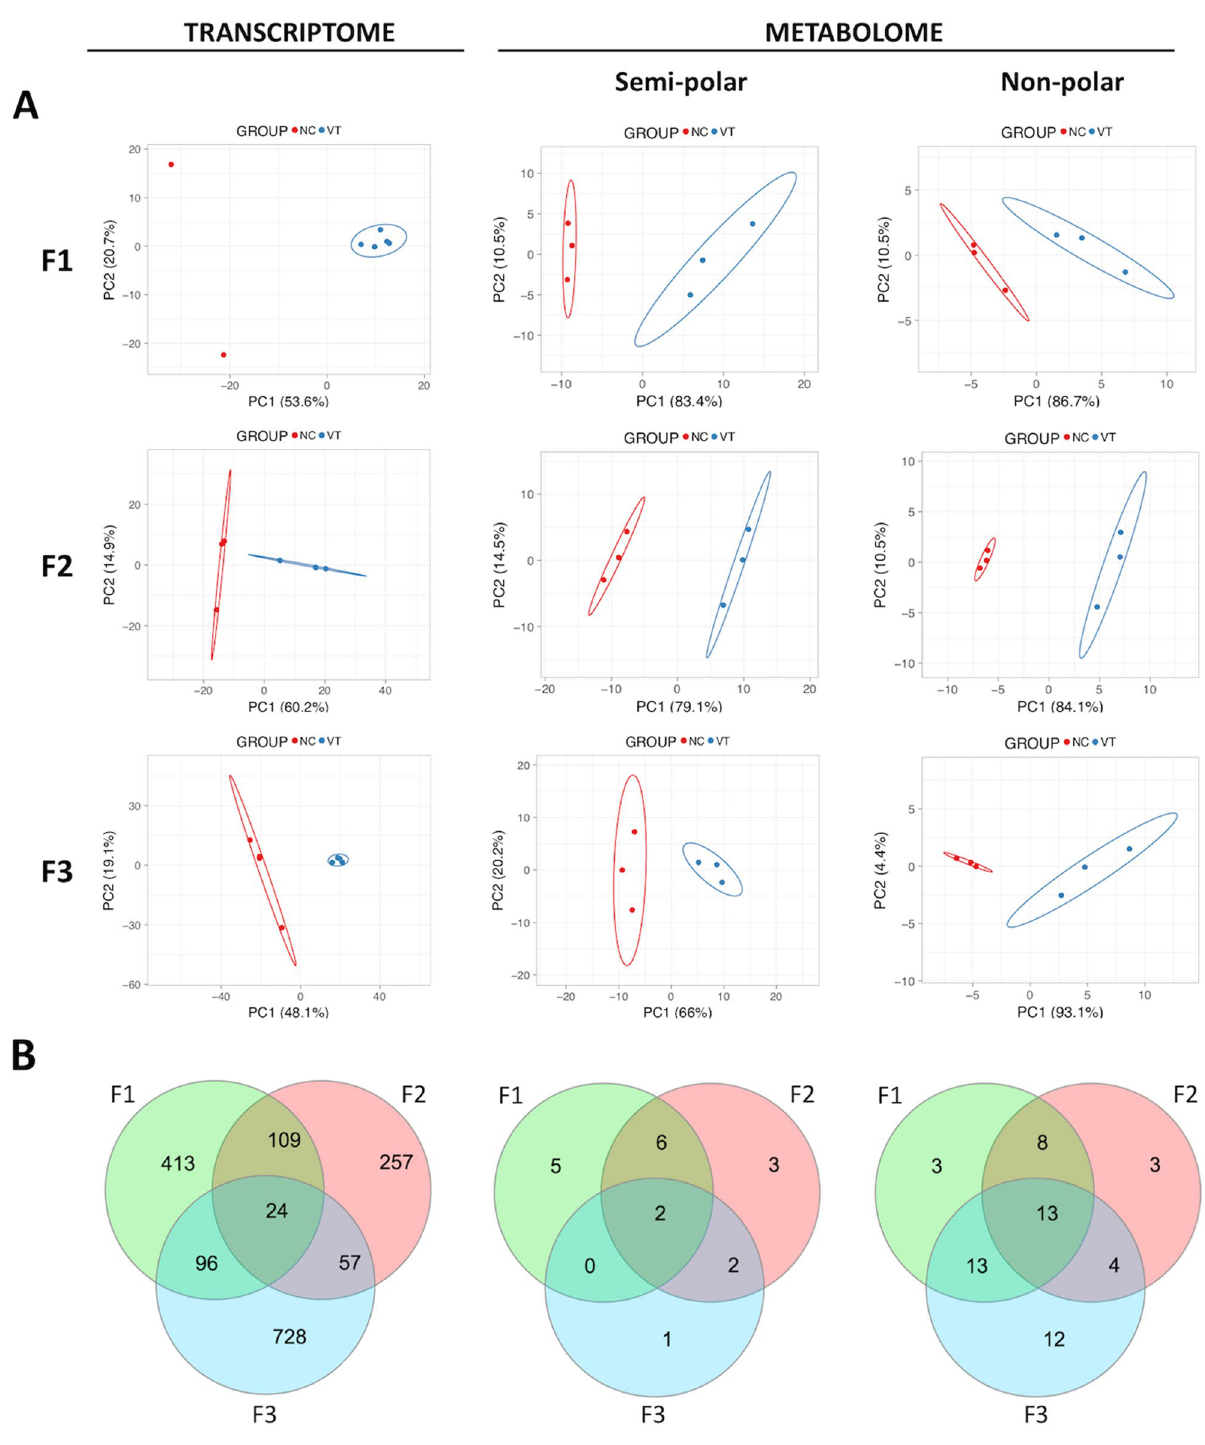
Figure 3. Molecular analysis of the liver samples collected from adult males derived from vitrified- transferred embryos (VT) and naturally-conceived (NC), which was compared in each generation (F1, F2, F3). ( A ) Principal Component Analysis (PCA) of the transcriptome, semi-polar metabolome and non-polar metabolome. The representation of sample variability between the experimental groups was performed taking into account only the differentially expressed transcripts or differentially accumulated metabolites. ( B ) Venn diagram summarising differentially expressed transcripts and targeted metabolites between NC and VT progenies in F1, F2, F3, and those commonly present between